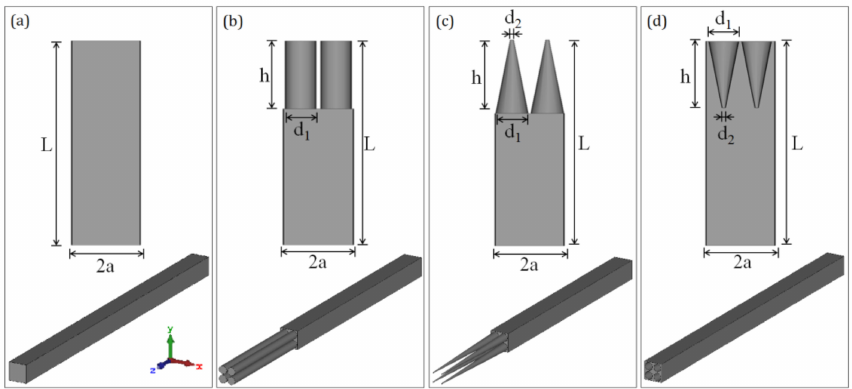
Figure 2. The dimensional distributions and 3D models of di ff erent nanostructures in the simulation: ( a ) bare silicon, L = 15 µ m, a = 400 nm; ( b ) nanocylinders on the Si substrate, h = 5 µ m, d 1 = 350 nm, L = 15 µ m, a = 400 nm; ( c ) nanotips on the Si substrate, h = 5 µ m, d 1 = 350 nm, d 2 = 40 nm, L = 15 µ m, a = 400 nm; ( d ) nanoholes on the Si substrate, h = 5 µ m, d 1 = 350 nm, d 2 = 40 nm, L = 15 µ m, a = 400